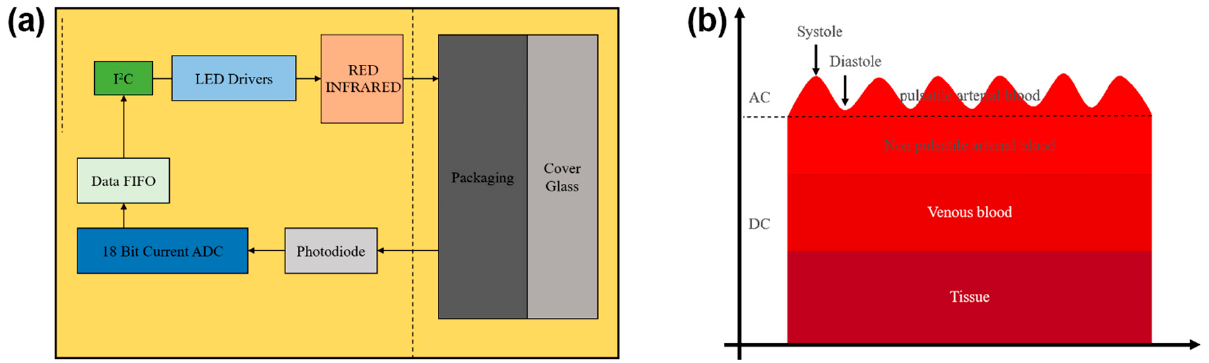
Figure 3. The system block diagram of the sensor ( a ); The measurement principle of a typical PPG signal ( b ).